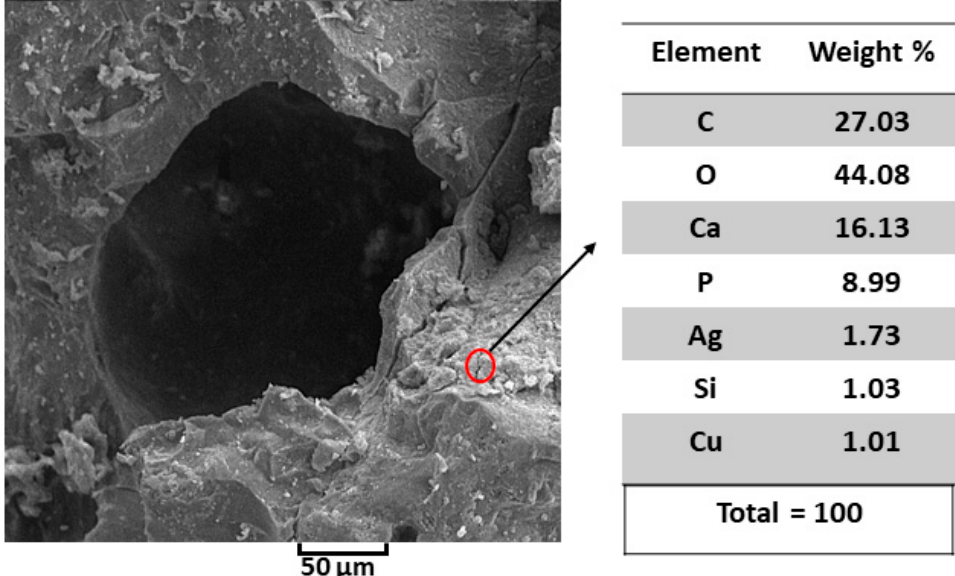
Figure 11. SEM EDAX data for Ag-doped HA+PVTMS scaffold.